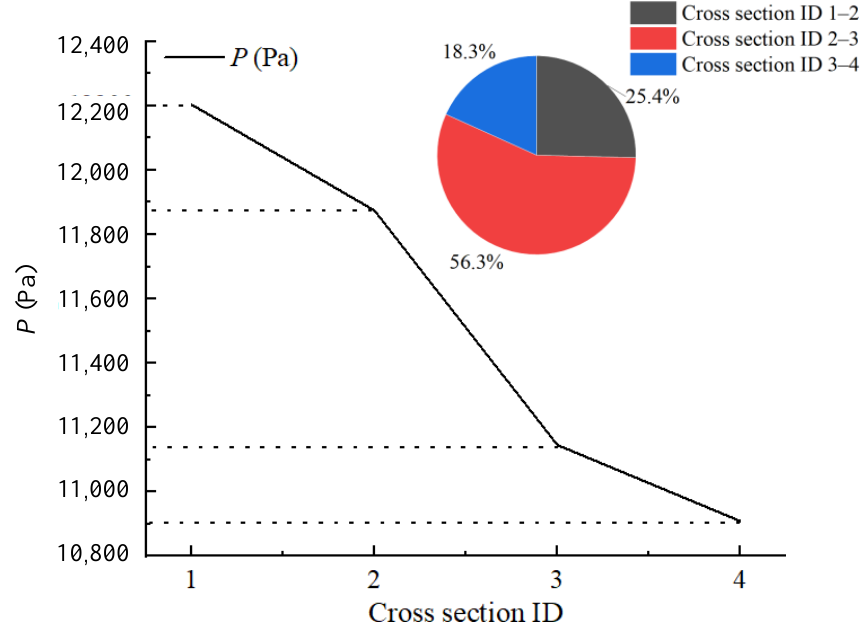
Figure 14. Local heat transfer capacity vs. cross-section ID, Re in = 2500.